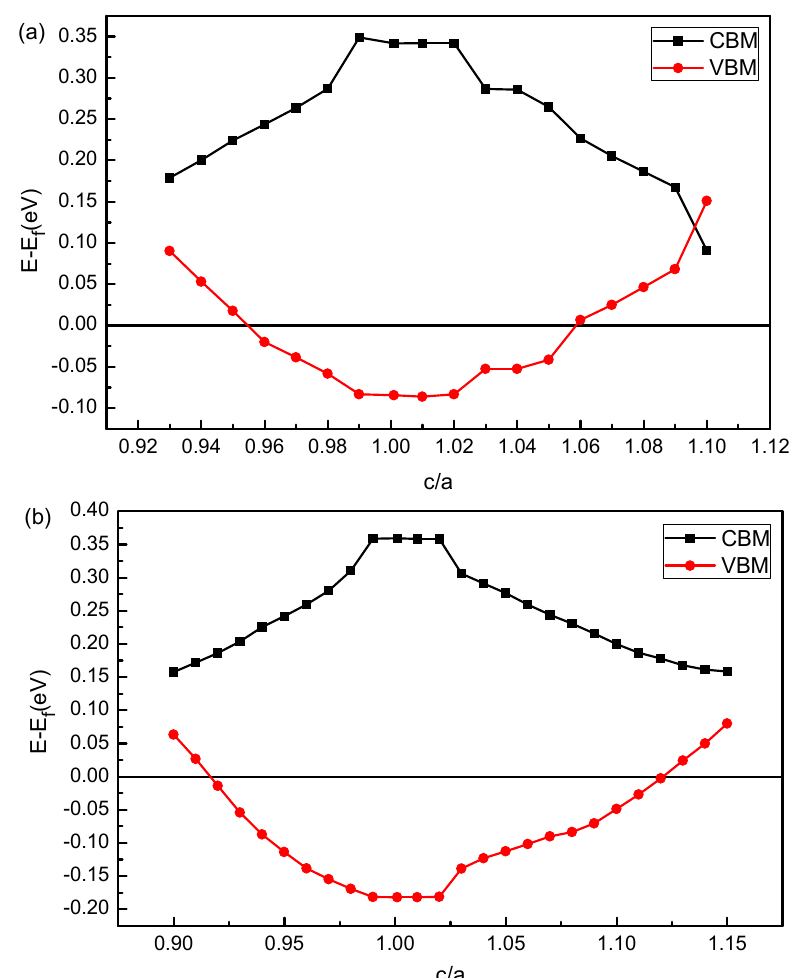
Figure 11. CBM and VBM in the minority channel as a function of c/a ratio (TD) for ZrRhTiAl ( a ) and ZrRhTiGa ( b ).